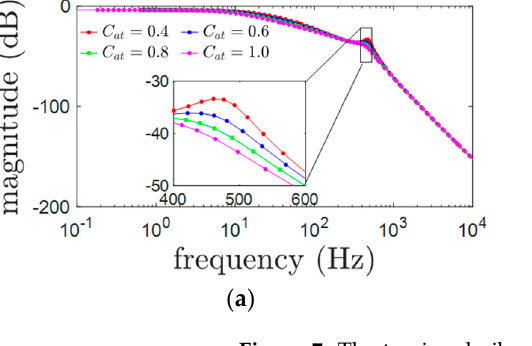
Figure 7. The torsional vibration of the flywheel rotor along the axial direction. ( a ) The torsional vibration amplitudes of the flywheel rotor with different damping coefficients. ( b ) The torsional vibration amplitudes of the flywheel rotor with different stiffness coefficients.